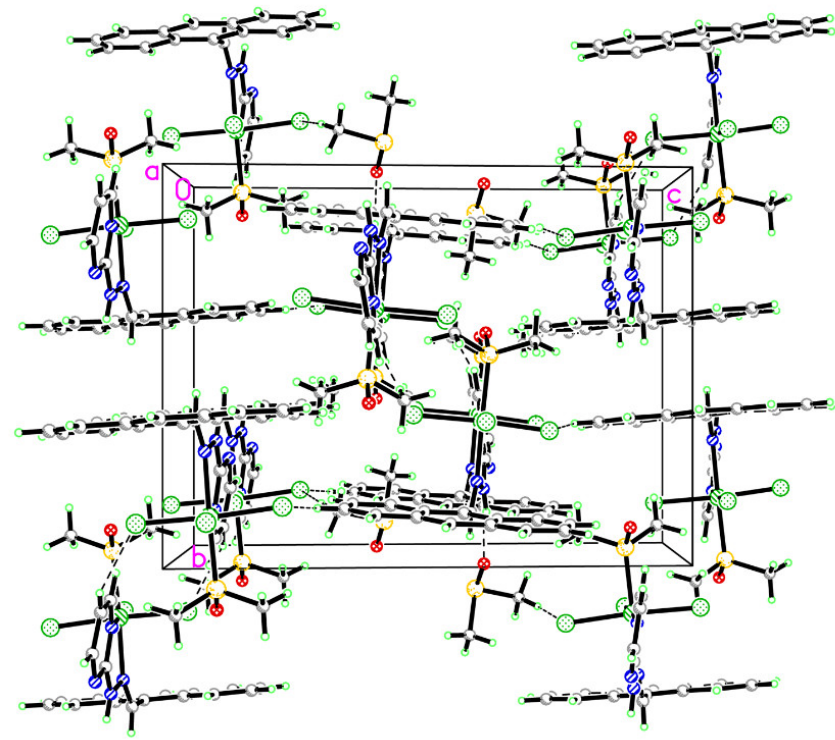
Figure 2. The packing diagram of the crystal structure of 9-PMAH-Rh viewed parallel to the a-axis, showing the C–H ··· Cl and N–H ··· O hydrogen bonds (shown as dashed lines).